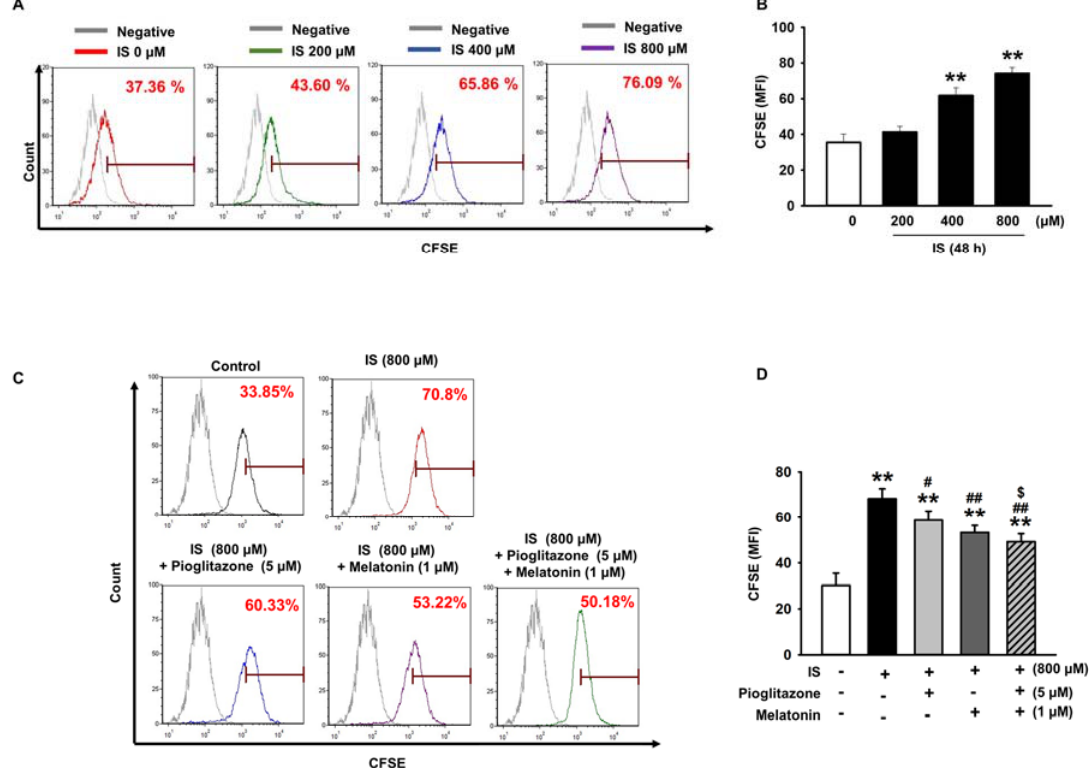
Figure 2. Pioglitazone and melatonin restore cell proliferation reduced by IS. ( A , B ) The images show carboxyfluorescein succinimidyl ester (CFSE)-labeled MSCs exposed to IS (0–800 µ M) for 48 h; cell proliferation was assessed by fluorescence-activated cell sorting (FACS) analysis of the dilution of CFSE in the same number of viable cells ( n = 3). The values represent the mean ± SEM; ** p < 0.01 vs. control (ANOVA, using Dunnett’s post-hoc test); ( C ) the graphs show CFSE-labeled IS-exposed MSCs pretreated with pioglitazone and melatonin; ( D ) FACS analysis of the dilution of CFSE in the same number of viable cells ( n = 3). The values represent the mean ± SEM; ** p < 0.01 vs. control, # p < 0.05 and ## p < 0.01 vs. IS only, $ p < 0.05 vs. pretreatment with pioglitazone or melatonin and IS (ANOVA, using Tukey’s post-hoc test).